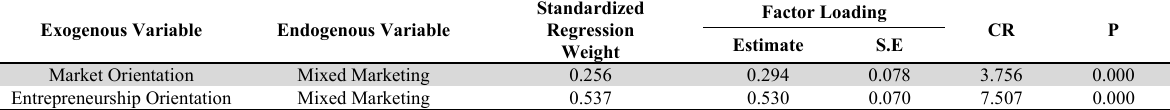
Second Hypothesis SEM Test Results. Market orientation and entrepreneurship orientation towards the mixed marketing